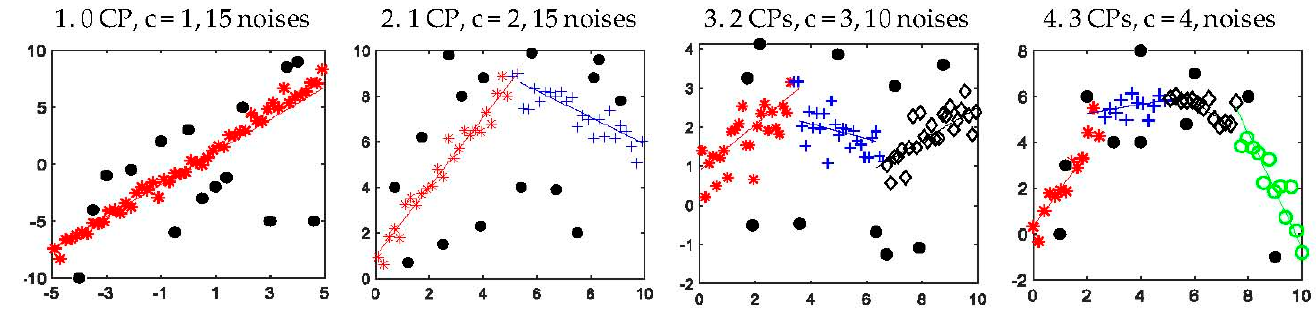
Figure 9. Models used for deciding the number of segments based on the suggested indices. Table 5. Deciding the number of segments for the models in Figure 9. ( i ) Using EMT1